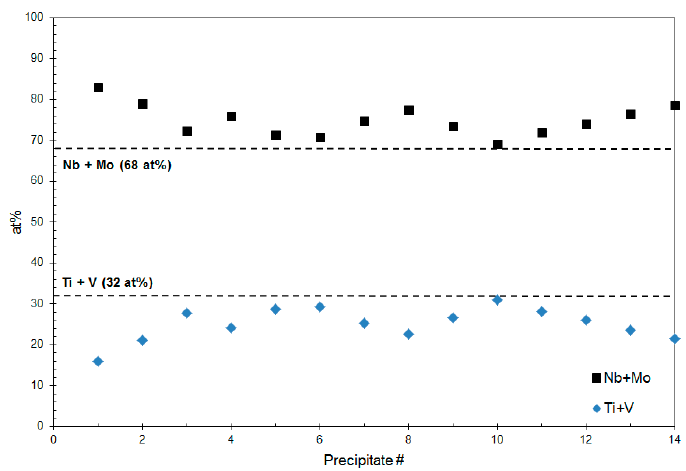
Figure 10. Measured (Nb + Mo) composition (squares) and measured composition (Ti + V) (diamonds) vs. predicted combined compositions (dashed lines).